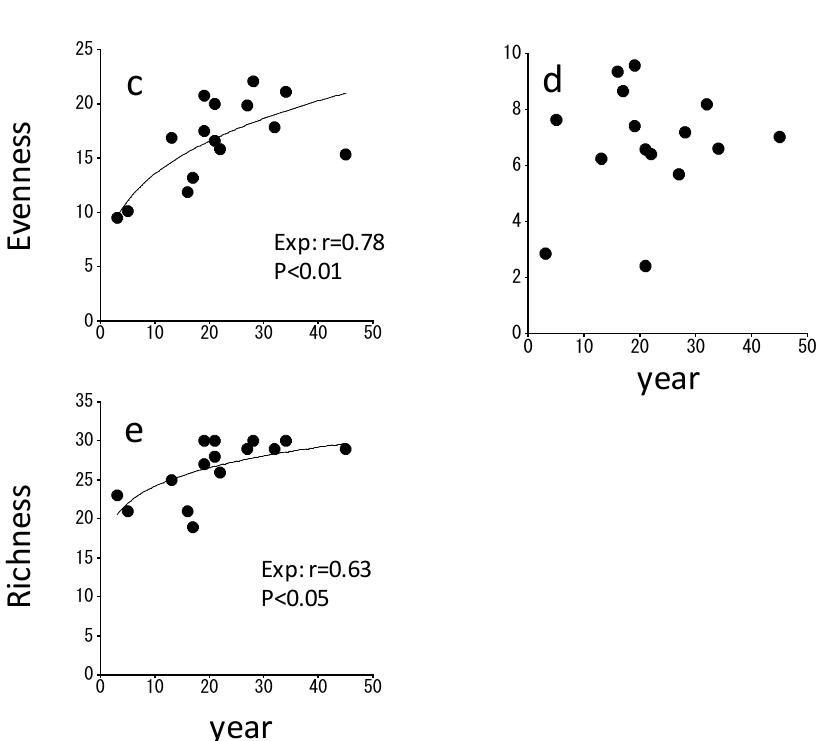
Figure 2. Relationship between site age and average microbial catabolic activity ( a and b ) and catabolic evenness ( c and d ) as determined by Biolog and substrate-induced respiration (SIR) methods, and between site age and catabolic richness as determined by Biolog ( e ). Richness is not presented for the SIR data because the soil microbial communities responded to every substrate at every site. Average microbial catabolic activity in Biolog indicates average well-color development (AWCD).